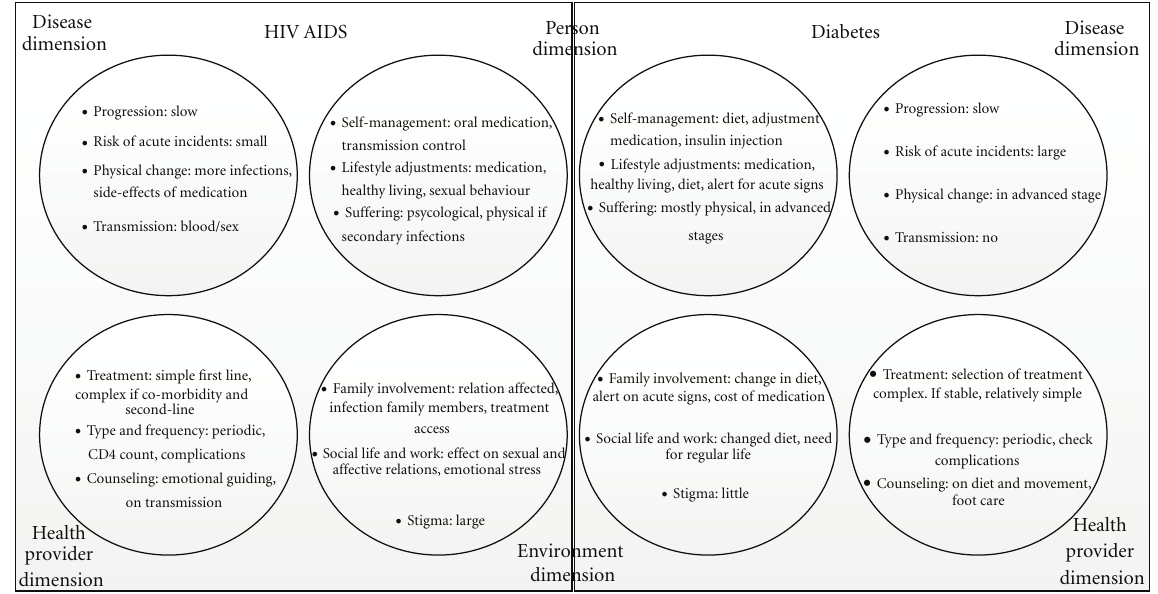
Figure 2: Comparing the chronicity dimensions of HIV AIDS and